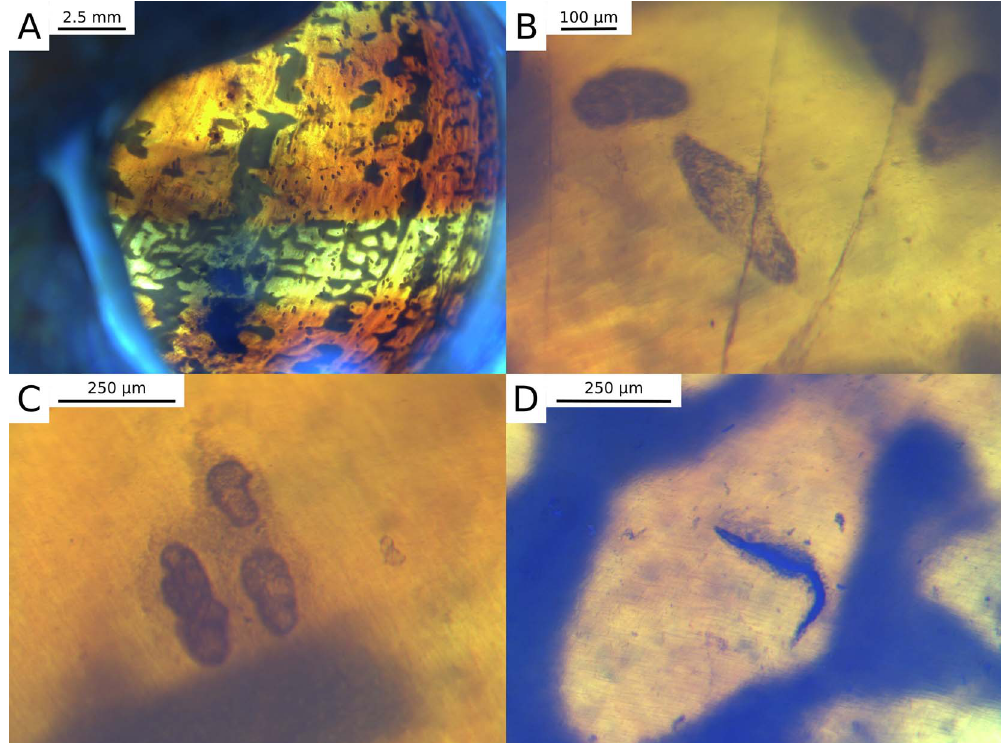
Figure 1. Backlit views of metazoan parasites trapped in the shell of Cornu aspersum : trematode cercariae (A, B, C), and nematode (D). Small cracks of the inner shell layer (B) can be seen above the cercariae and were considered indicative of damage on the shell after it covered cercariae. Note the accumulation of dark adhering cells around or above the parasites for both cercariae (C) and nematodes (D). High- resolution versions of these images are archived in Zenodo